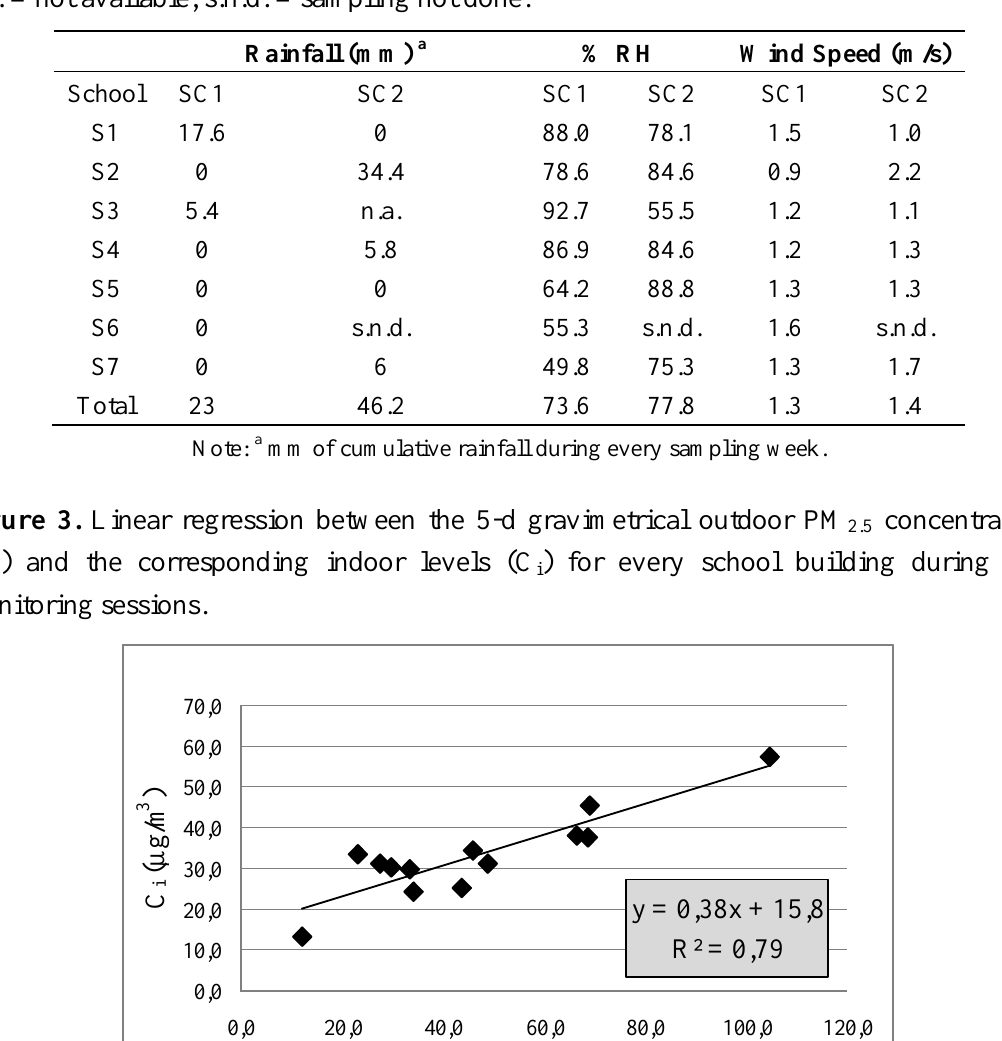
Table 2. Summary of the 5-d weather conditions during the experimental campaigns; n.a. = not available, s.n.d. = sampling not done.